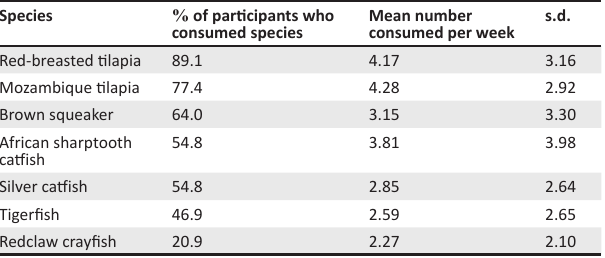
TABLE 3: Percentage of participants who consumed the species as listed, and mean number of fish or crayfish consumed per week. Species % of participants who Mean number consumed species consumed per week